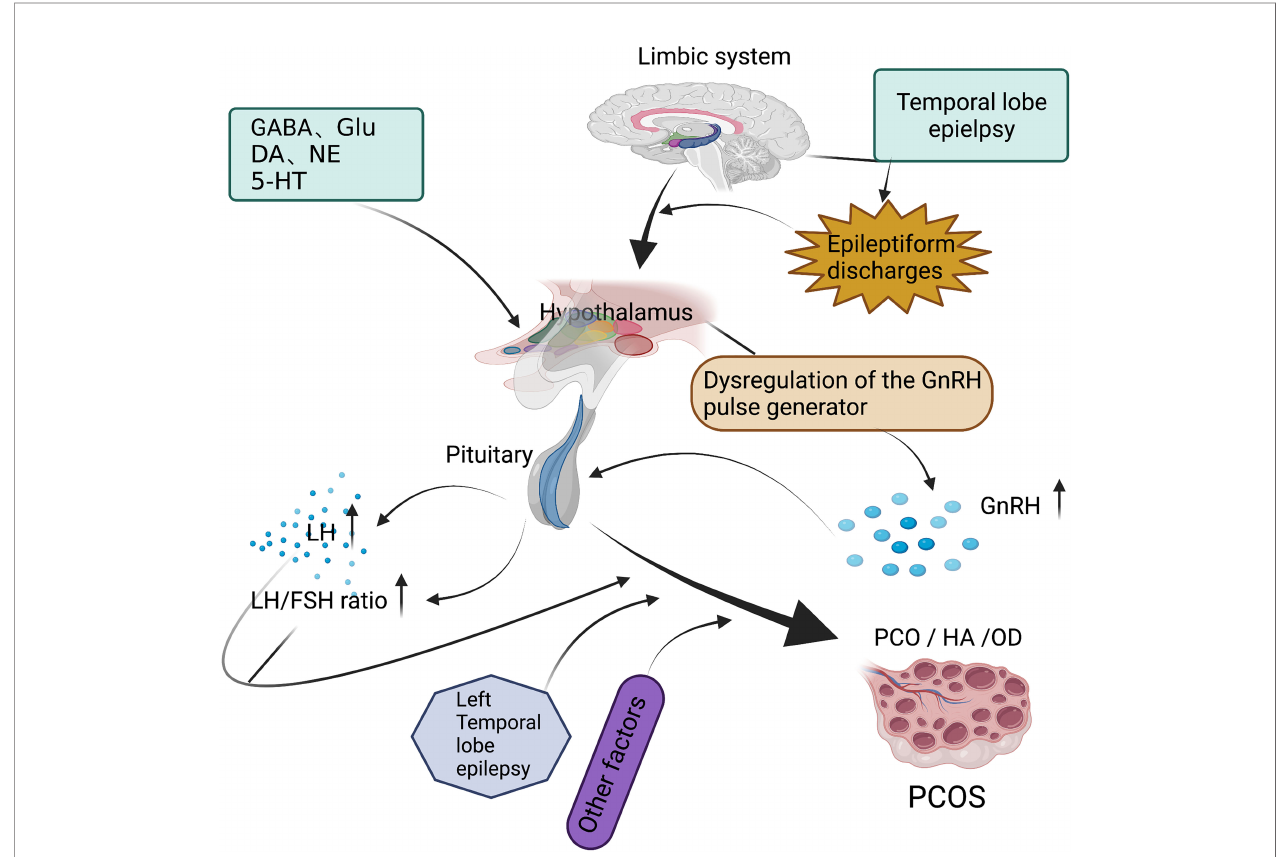
FIGURE 1 | Regarding the mechanism of polycystic ovary syndrome (PCOS) in temporal lobe epilepsy (TLE), epileptiform discharges toward the hypothalamus interfere with the activity of the gonadotropin-releasing hormone (GnRH) pulse generator and neurotransmitters affect the excitability of GnRH neurons to enhance the frequency of GnRH secretion, which in turn leads to an increase in luteinizing hormone (LH) secretion and an increase in the ratio of LH/follicle stimulating hormone (FSH). Laterality (more common in left TLE) and other factors, such as age at seizure onset, type of epilepsy, and activity of epilepsy, are all involved in